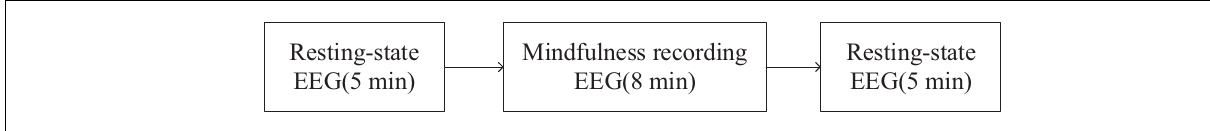
FIGURE 1 | Experimental paradigm of the proposed affective brain–computer interface.